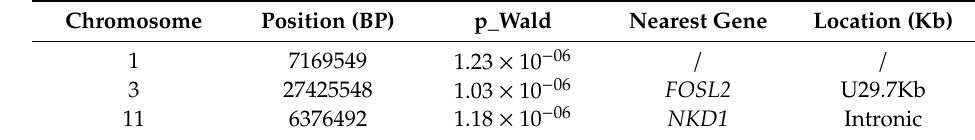
FOSL2: FOS Like 2, AP-1 Transcription Factor Subunit; NKD1: naked cuticle homolog 1